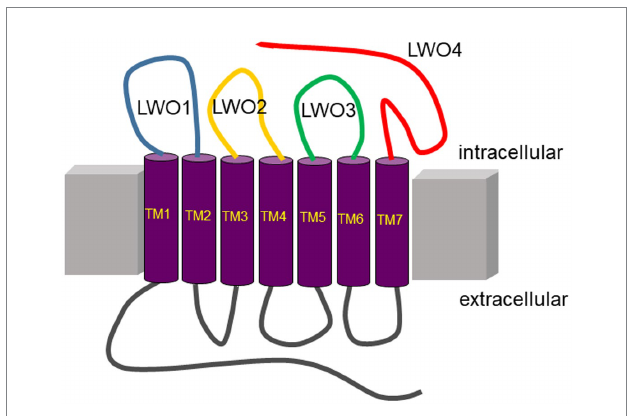
FIGURE 1 Topography of long wavelength opsin from European robin. Peptides used in the present study are on the intracellular (cytoplasmic) side of the membrane protein indicated by the colored loops (blue, LWO1; yellow, LWO2; green, LWO3; red, LWO4). Extracellular loops are in grey. The seven transmembrane regions (TM1–TM7) are connected via the loops and are presented in